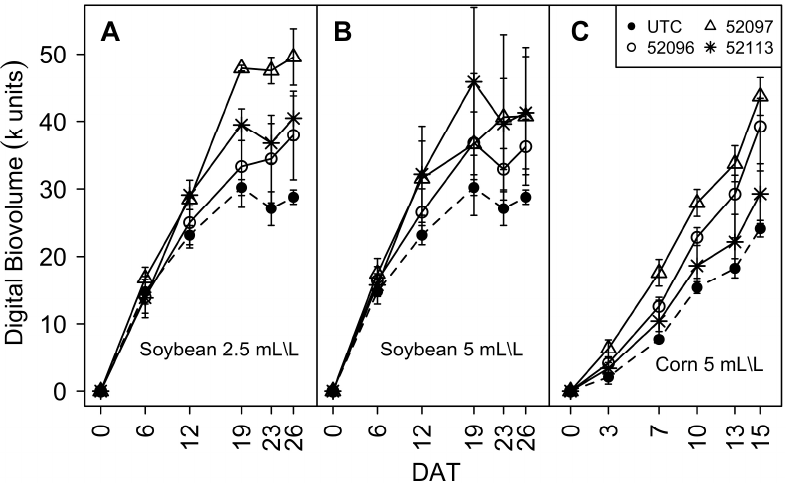
Figure 1. Mean values ± SE ( n = 5) of digital biovolume (DB) measured on ( A ) soybean plants treated at lower dosage, ( B ) soybean plants treated at higher dosage, and ( C ) corn plants treated at higher dosage. Dashed lines and filled black circles ( ● ) identify the untreated control plants (UTC).